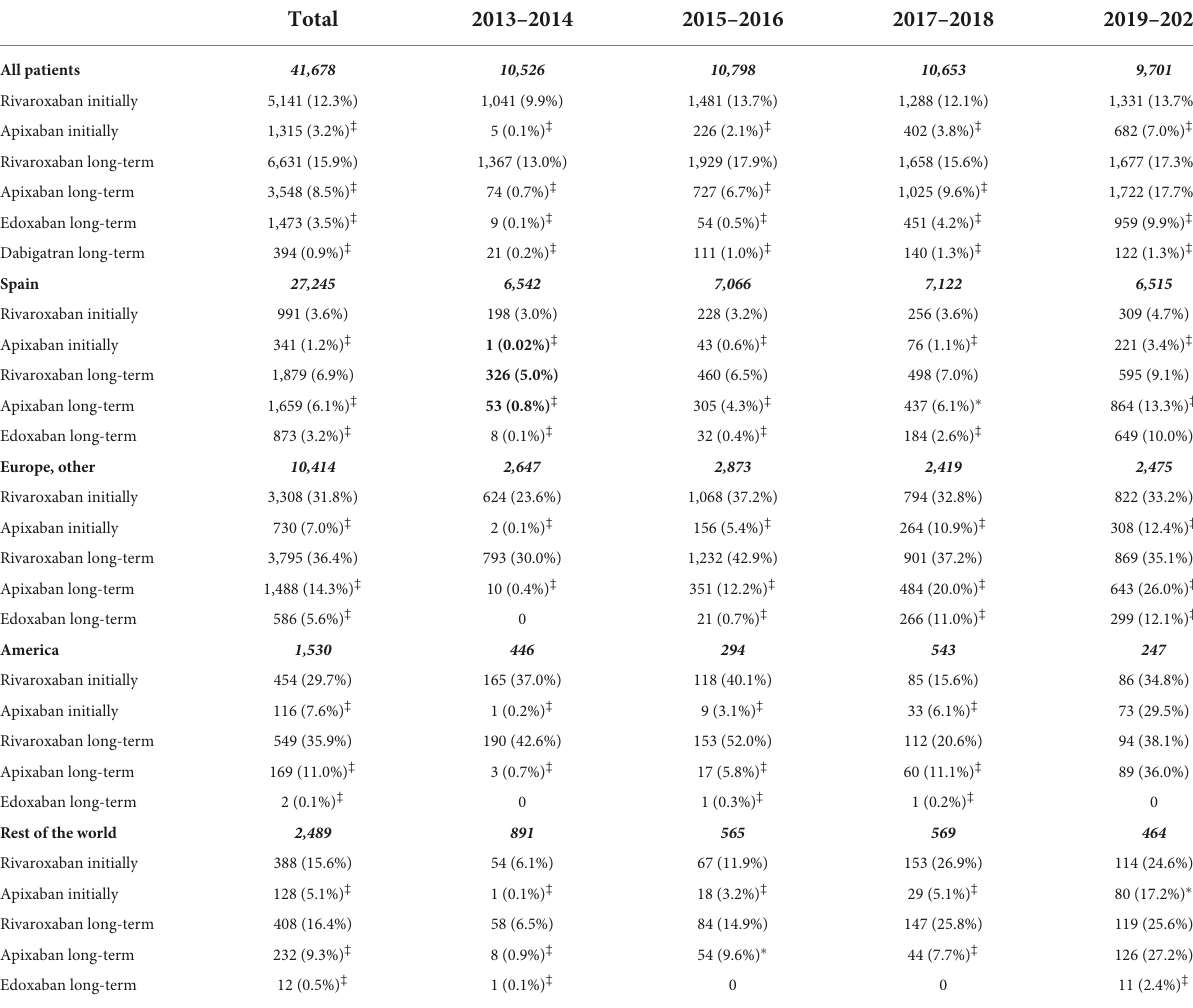
TABLE 1 Prescription of DOACs over time in different